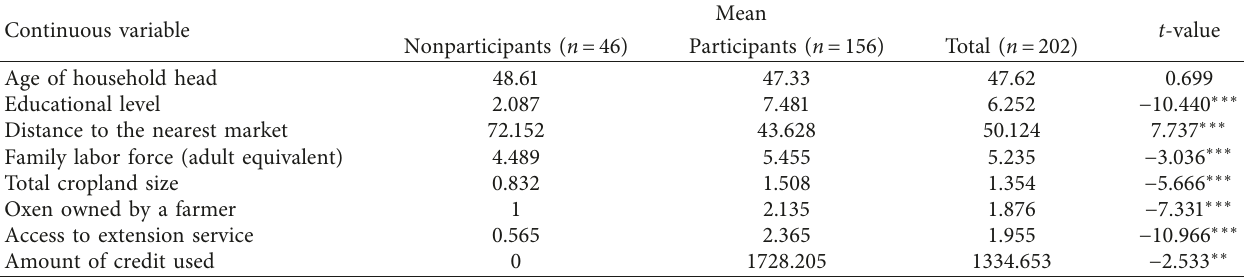
Table 1: Two potato market participations and weighted mean comparison test of continuous